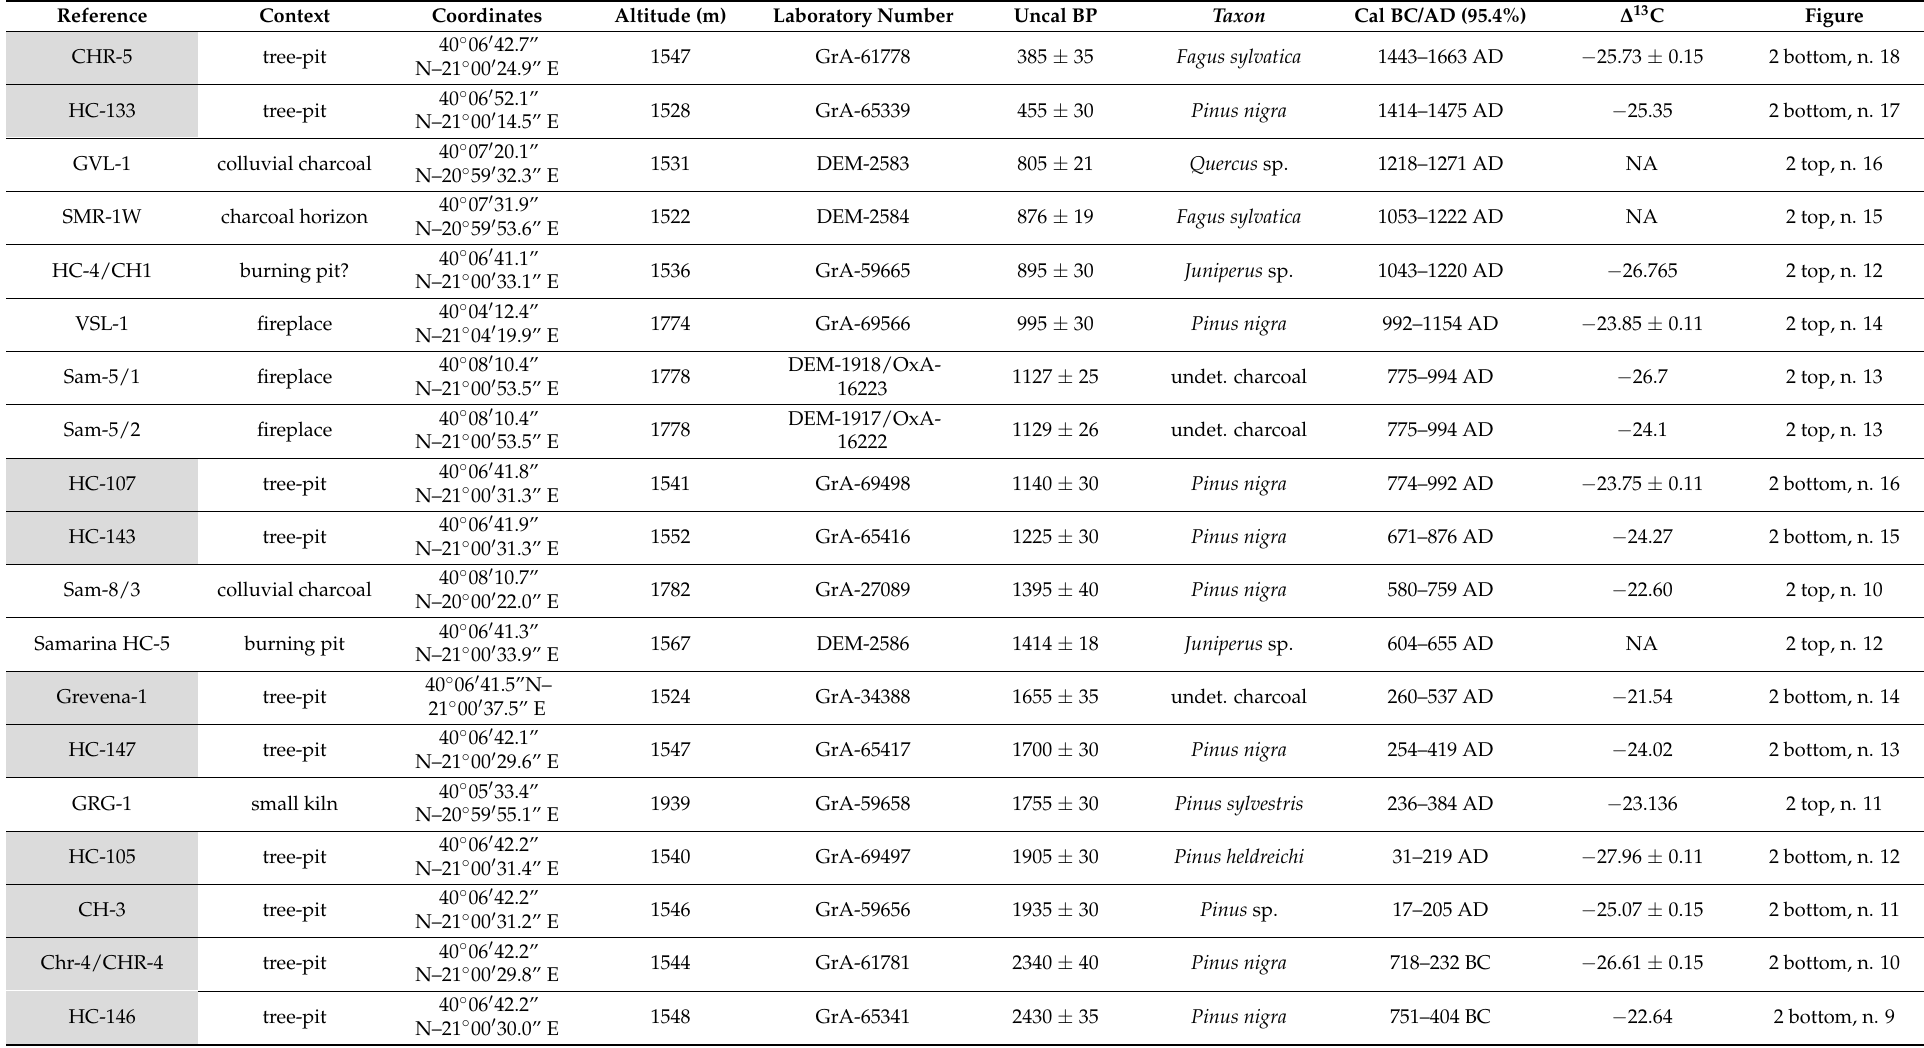
Table 1. List of all the radiocarbon-dated sites reported in the text. The HC tree-pit results are marked in grey (NA = Not Available). Calibrations according to OxCal